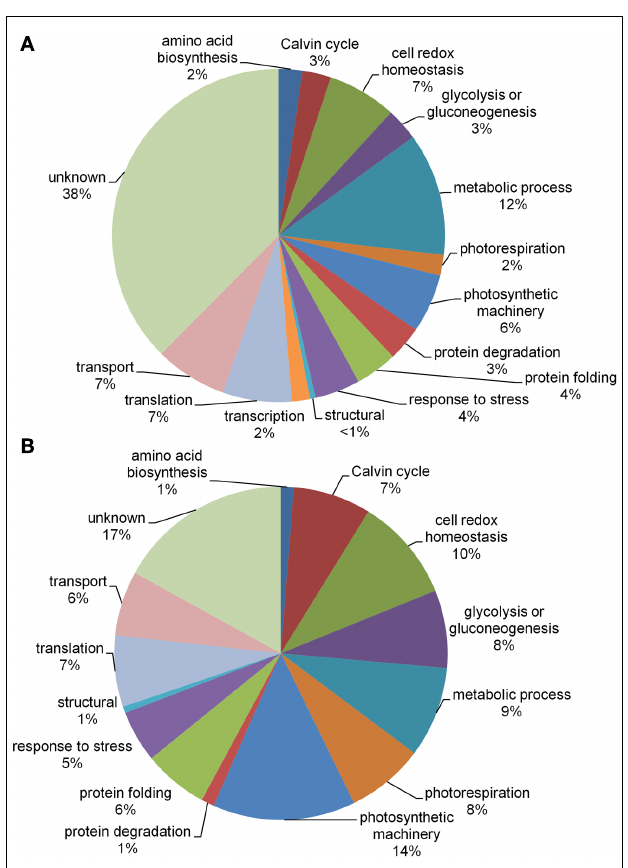
FIGURE 3 | Relative water content (RWC) of flag leaf. Data represents the mean of 5 biological replicates, plus/minus the SD. WS, water stressed at 5days;WP1, wilting point 1 for intolerant cultivar at day 14;WP2, wilting point 2 for intolerant cultivar at day 24;